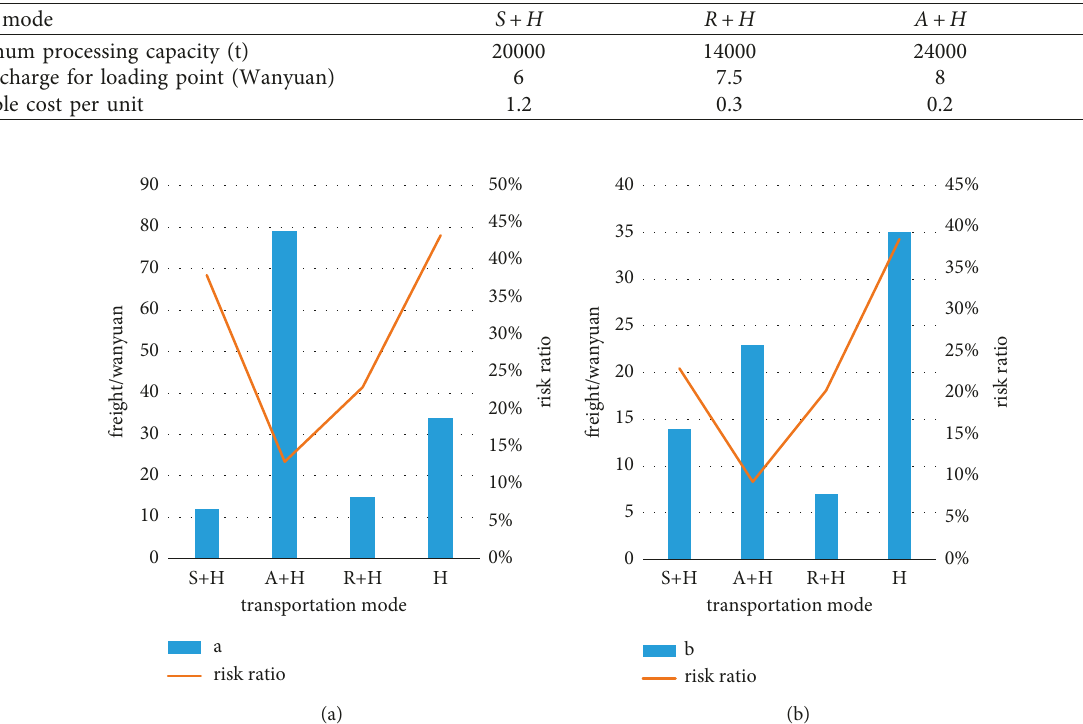
Figure 7: (a) Freight and (b) risk rates for a single shipping method. Table 3: Combined route freight (unit: yuan/t).